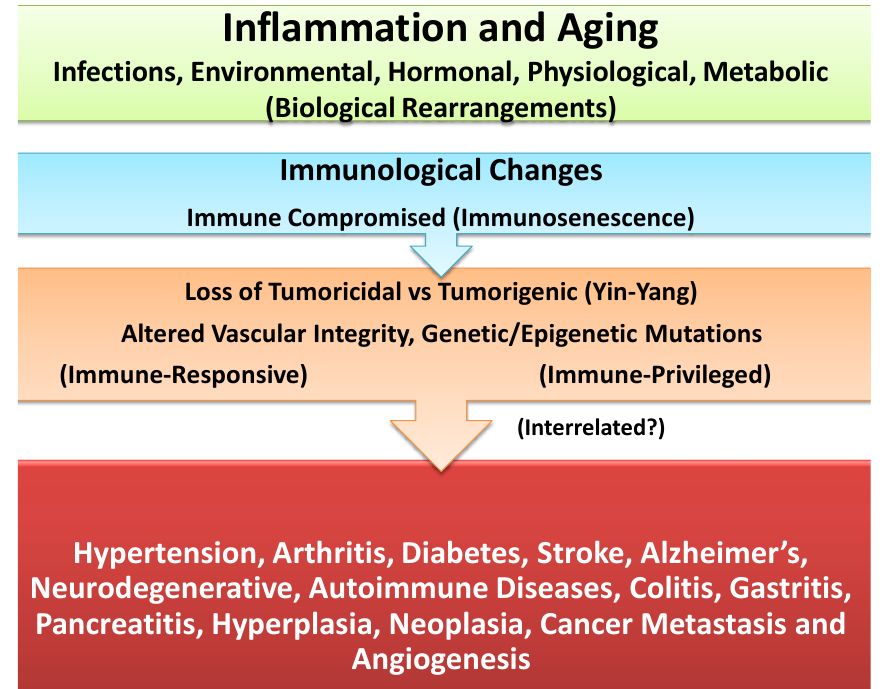
Figure 4. Schematic representation that longevity and oxidative stress are co-morbidity and co-mortality risk factors in the induction of biological and immunological senescence that are involved in instabilities of cellular and genetic/epigenetic and vascular functions. The altered cellular functions differentially impact immune-privileged and immune-responsive target tissues and lay a foundation for initiation, progression and manifestation of a wide range of age-associated chronic diseases and/or site-specific cancers that are potentially